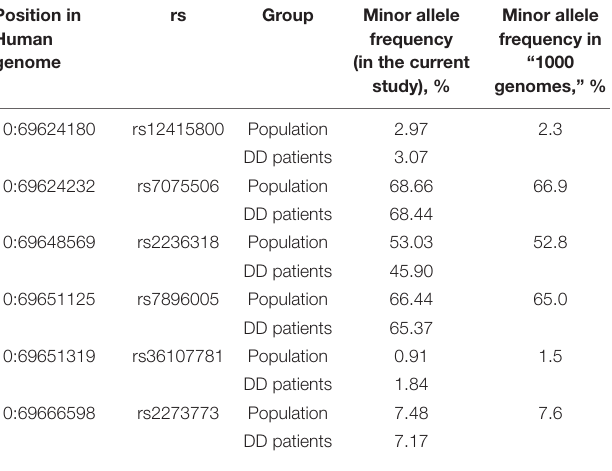
TABLE 4 | Allele frequencies of the most frequent SIRT1 SNPs in general Russian population ( N = 1024) and in Depressive Disorder (DD) patients ( N = 244) in comparison with the “1000 genomes” study (data for European